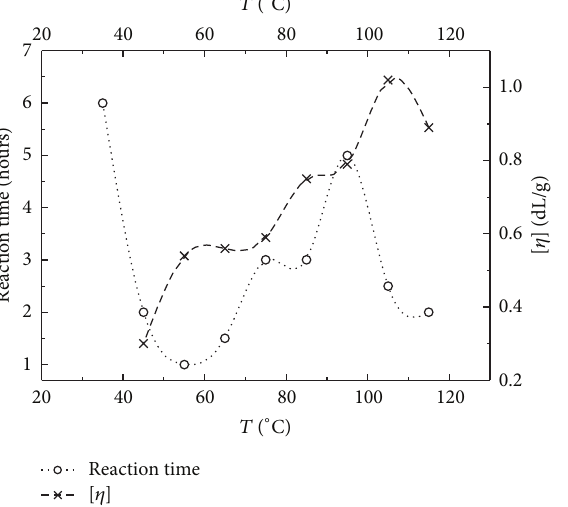
Figure 4: Graphs of dependences of polyPDL yield, reaction time (visual fixation of solidification of reaction medium) and product intrinsic viscosity on [M]/[E] ratio. Reaction conditions: 𝑇 = 65 ∘ C, monomer concentration-50 wt.%.